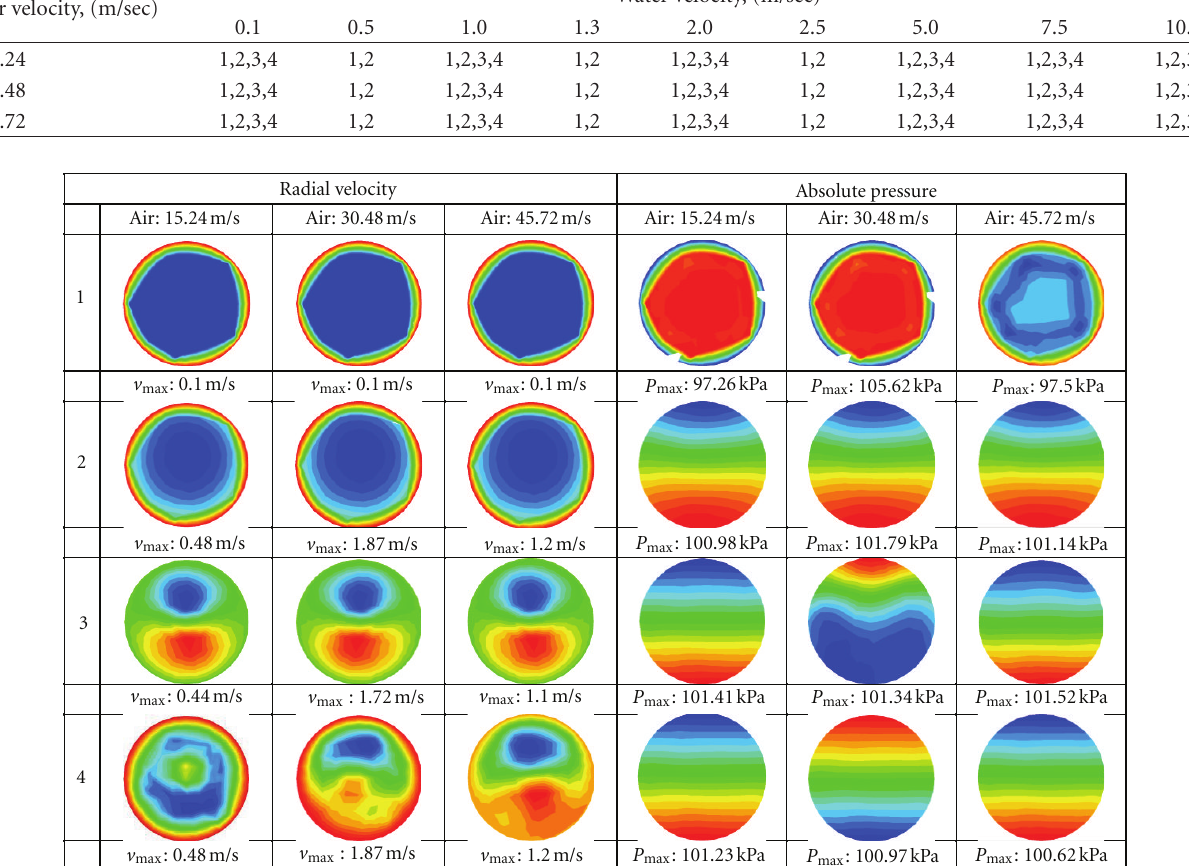
Figure 3: CFD-predicted velocity and pressures in elbow1 at water